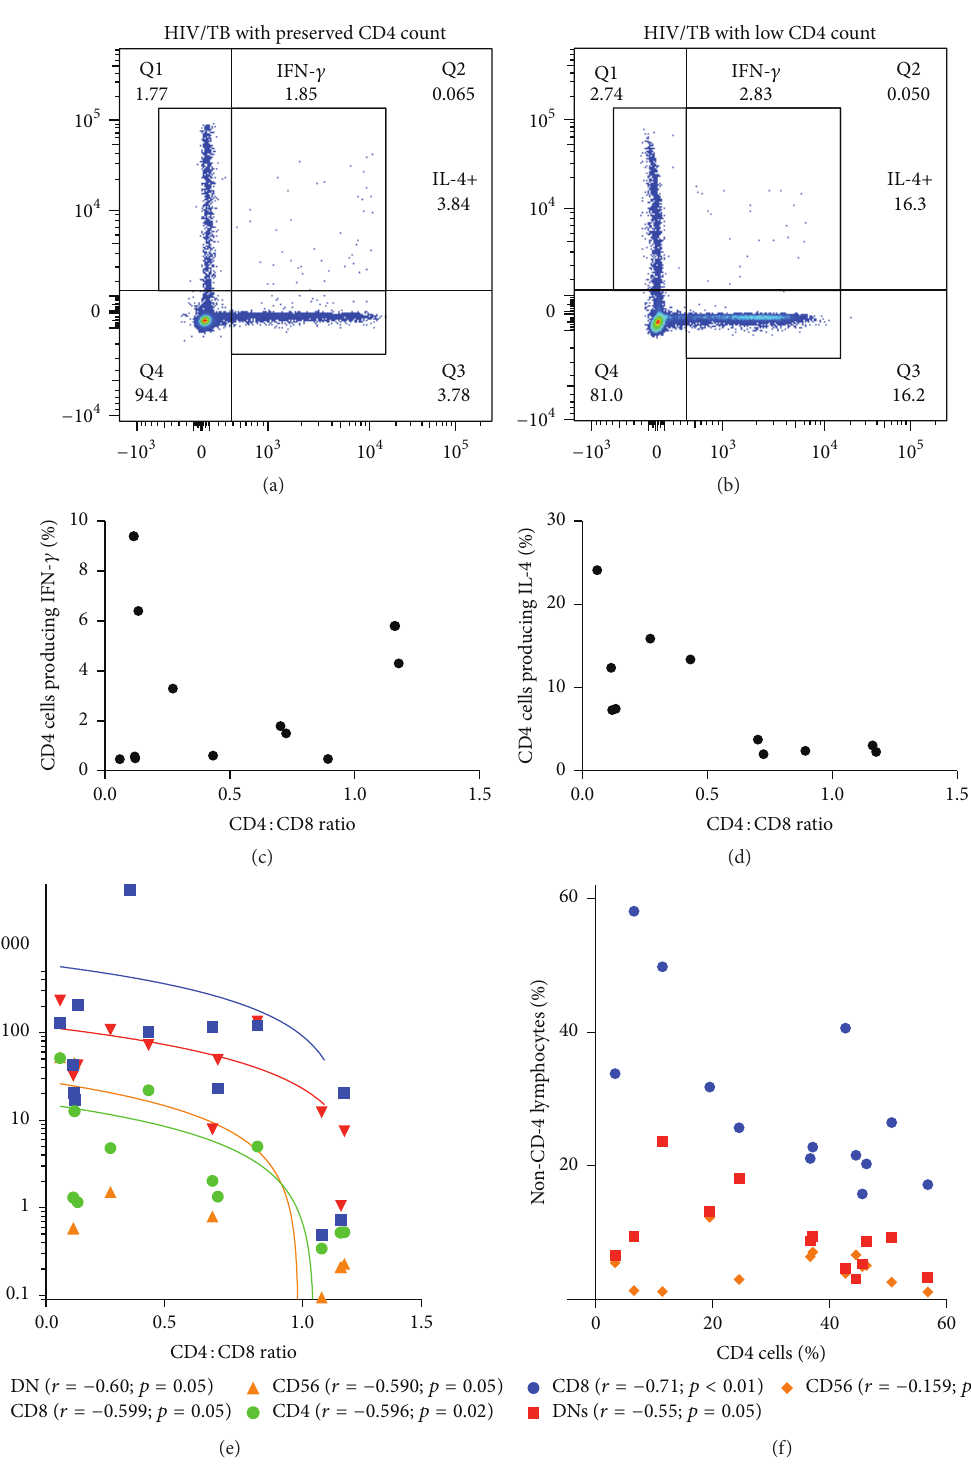
Figure 1: HIV progression increases immune skewing towards IL-4 and away from IFN- 𝛾 amongst CD4 + , CD8 + , Double Negative (CD3 + CD4 − CD8 − ), and CD56 + lymphocytes. PBMCs from HIV-TB coinfected patients were stimulated with Mycobacterium bovis (M. bovis ) lysate to measure the CD4, CD8, NK (CD56 + CD3 − ), and Double Negative (CD3 + CD4 − CD8 − ) lymphocyte response. (a and b) Representative dot plots illustrating definition of M. bovis IFN- 𝛾 and IL-4 responses based on CD4 cell count. Full gating strategy is available in Supplemental Figure2.(c)PercentageofCD4cellsproducingmycobacterial-specificIFN- 𝛾 basedonCD4 : CD8ratio.(d)PercentageofCD4cellsproducing mycobacterial-specific IL-4 based on CD4 :CD8 ratio. (e) Spearman correlation of the mycobacteria-specific IL-4:IFN- 𝛾 ratio based on the CD4 :CD8 ratio for CD4 cells, CD8 cells, CD56 cells, and Double Negative Lymphocytes. (f) Percentage of CD8 lymphocytes, CD56 lymphocytes, or Double Negative Lymphocytes based on declining CD4 cell